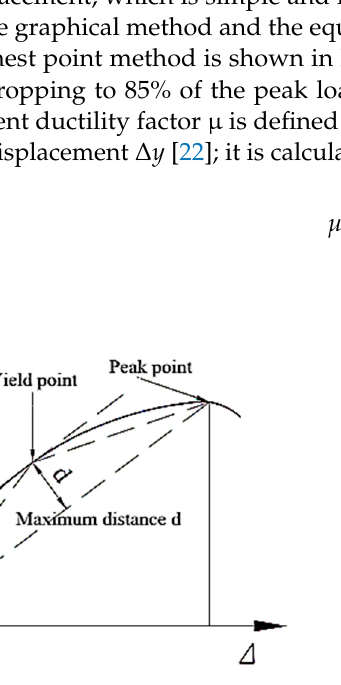
Figure 11. the farthest point method. Figure 11. The farthest point method.